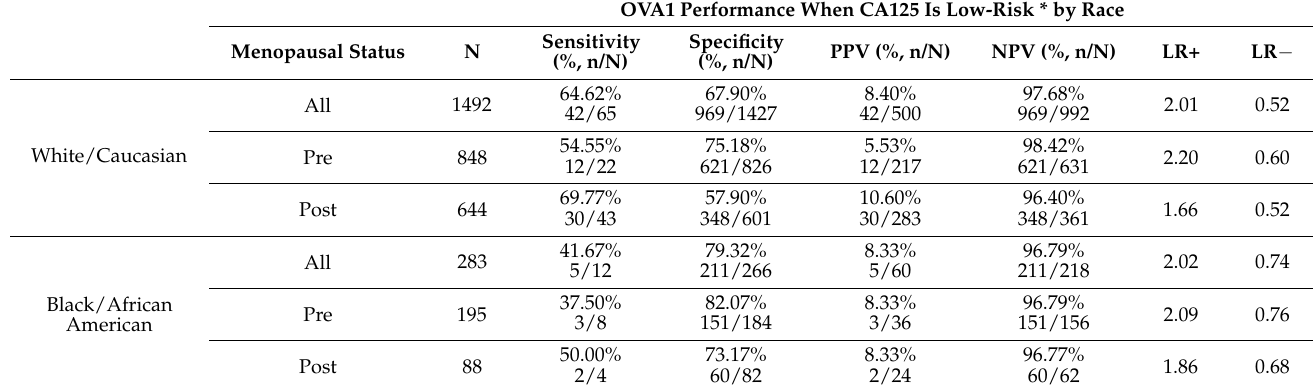
Table 3. OVA1 Performance Stratified by Race.